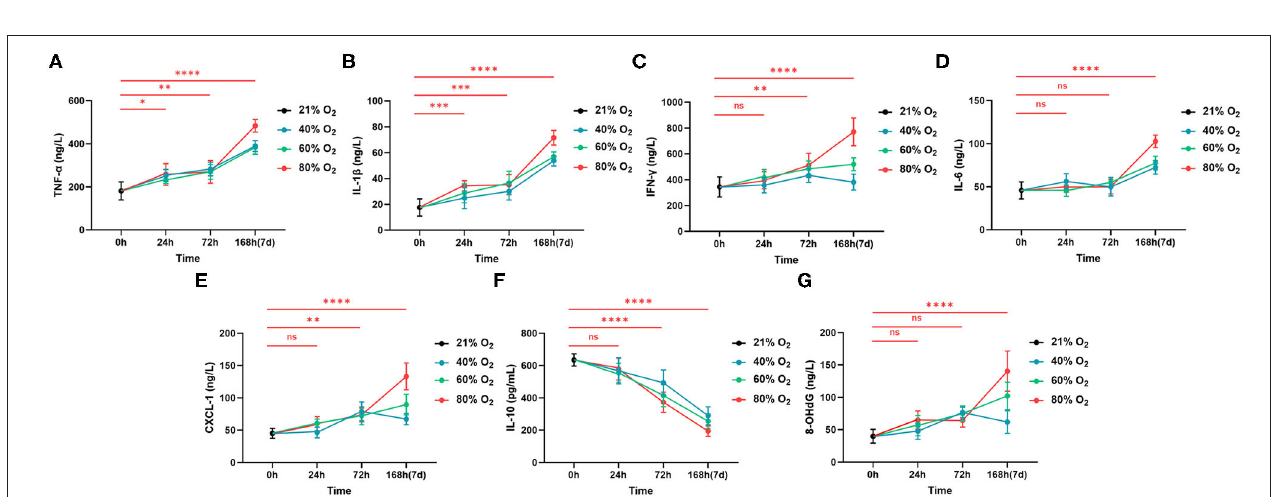
FIGURE 4 | Hyperoxia induces time- and dose-dependent intestinal inflammation ( n = 6). (A) The graph of concentrations of TNF- α . (B) The graph of concentrations of IL-1 β . (C) The graph of concentrations of IFN- γ . (D) The graph of concentrations of IL-6. (E) The graph of concentrations of CXCL-1. (F) The graph of concentrations of IL-10. (G) The graph of concentrations of 8-OHdG. * P < 0.05; ** P < 0.01; *** P < 0.001 **** P < 0.0001 ( P -values: 80% of oxygen group vs. the control group). Additionally, 80% of oxygen potentiated intestinal oxidative P < 0.0001), and CXCL-1 (72 h: P = 0.004, 168 h: P < stress (8-OHdG, 72 h: P = 0.0002, 168 h: P < 0.0001; Figure 4G ). 0.0001; Figures 4A–E ). However, 80% of oxygen decreased the Moreover, 40 and 60% of oxygen also induced more level of IL-10 (72 and 168 h: all P < 0.0001; Figure 4F ).